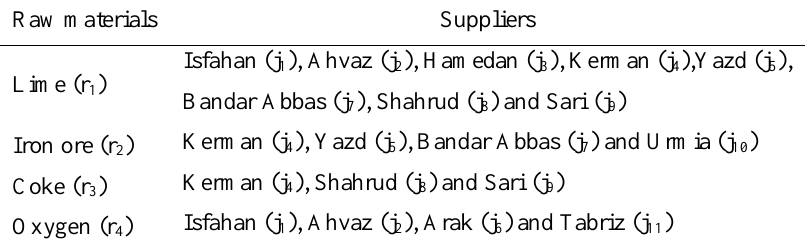
Table 1. Resource Place of Each Raw Material